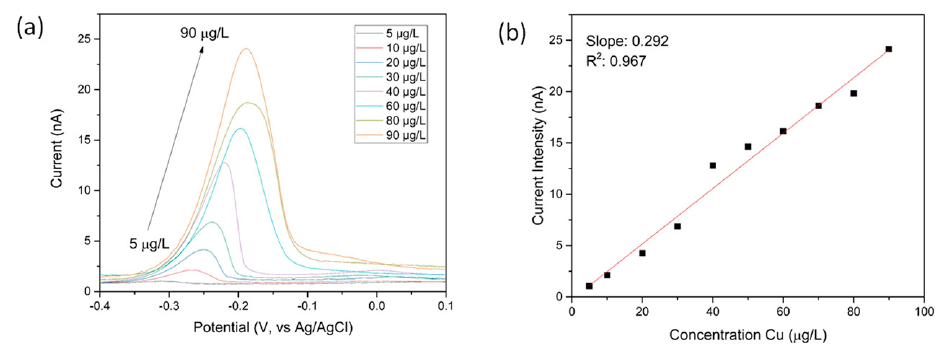
Figure 10. ( a ) Square wave stripping voltammograms of copper solutions acquired using electro- chemical pH control. The measurements were done in copper solutions at pH 7 with 1.7 V applied at protonator IDA during deposition; ( b ) Corresponding calibration line.